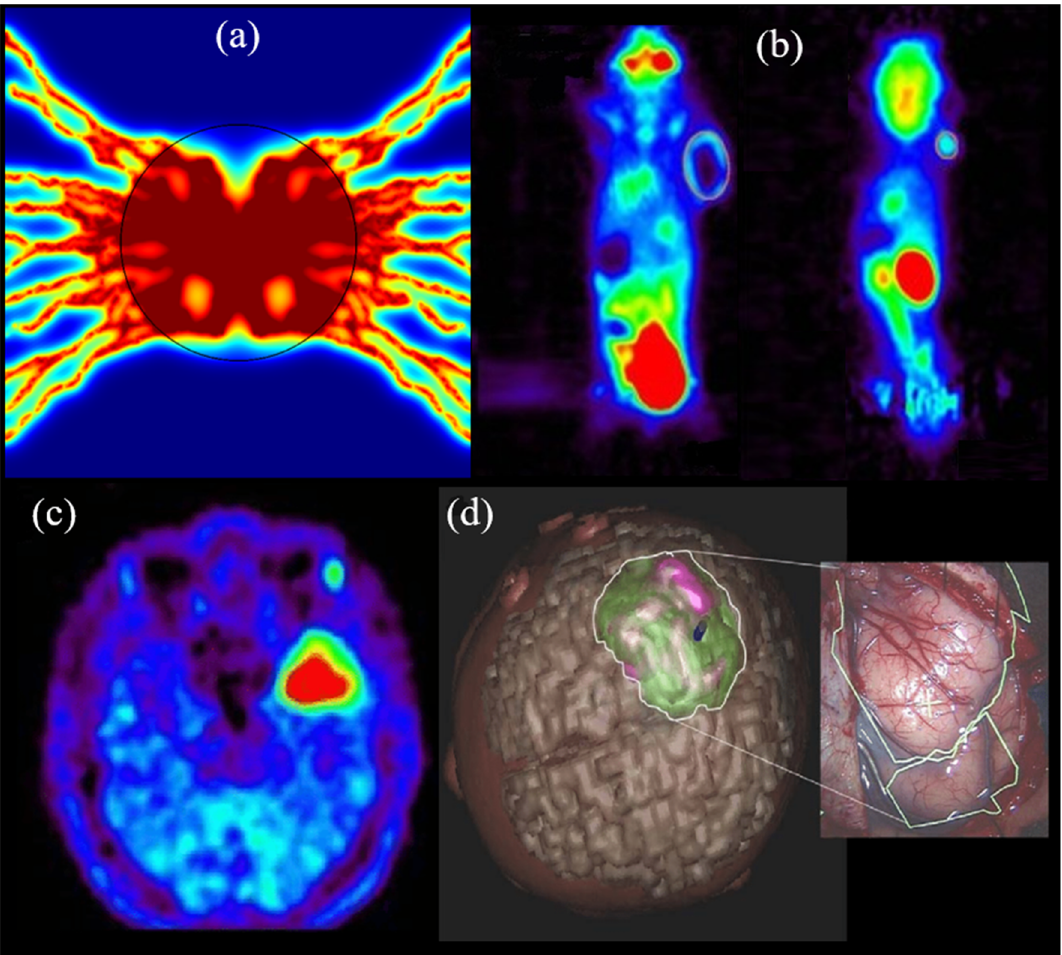
Figure 6. Qualitative validation of present computational results with longitudinal FDG-PET images of two tumor-bearing mice and a pediatric brain tumor. ( a ) Synthetic PET image that is generated by the current mathematical model. ( b ) Longitudinal FDG-microPET scans of mice with glioblastoma U87 (right picture) and adenocarcinoma MDA-MB-231 (left picture) tumor cells 42 . The tumors can be easily detectable on micro-PET images by red color regions. ( c ) Preoperative PET image in a 10-month-old boy with parietal ganglioglioma 43 . ( d ) Tumor contours with its vessels are illustrated in the preoperative 3D planning. Reprinted by permission from Refs. 42,43